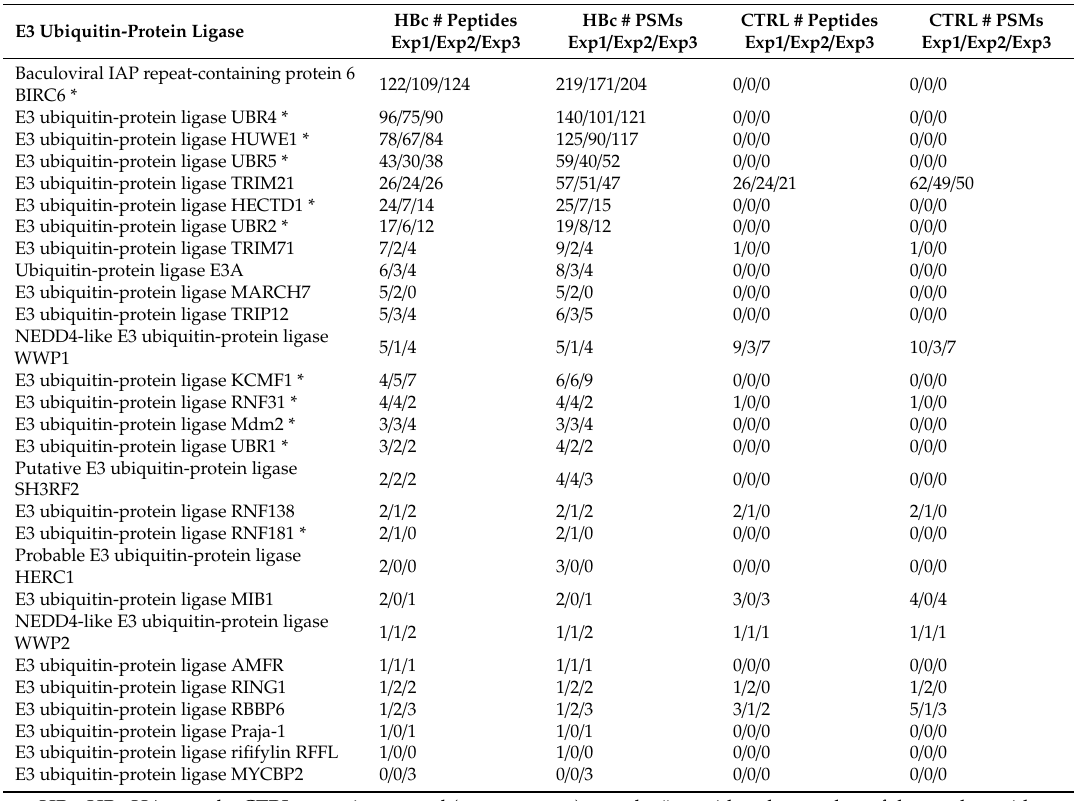
Table 2. E3 ubiquitin-protein ligases identified by shotgun LC-MS / MS analysis of proteins co-immunoprecipitated with HBc-HA expressed in HepG2-hNTCP cells. HBc # Peptides E3 Ubiquitin-Protein Ligase Exp1 / Exp2 /